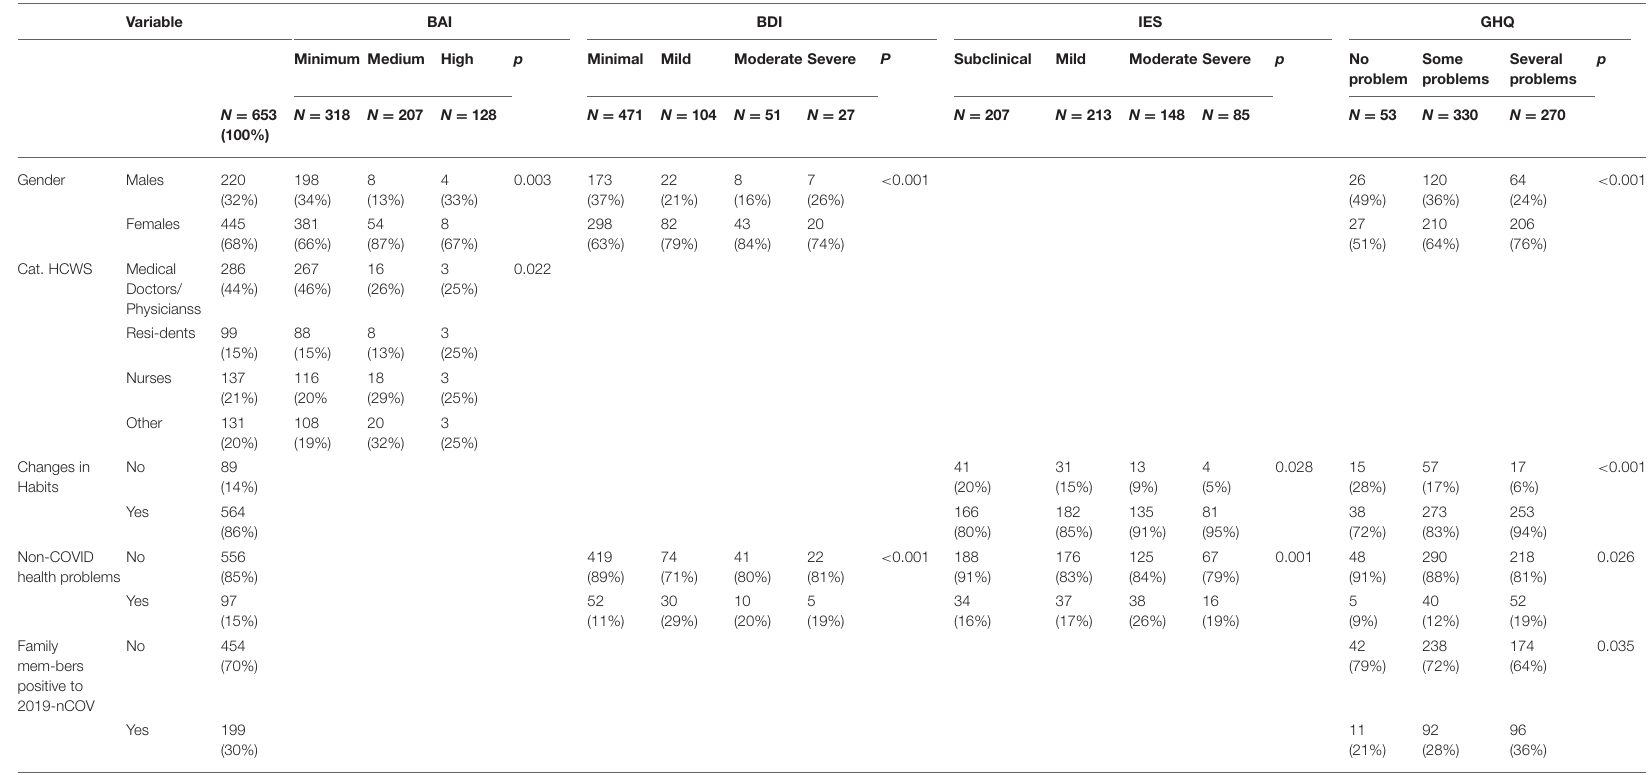
Only statistically significant differences (p < 0.05) are shown. Cat. HCWS, Category Healthcare Worker; BAI, Beck Anxiety Inventory; BDI, Beck Depression Inventory; IES, Impact of Event Scale; GHQ, General Health Questionnaire; p, p-Value; Min, Minimal; Mod,